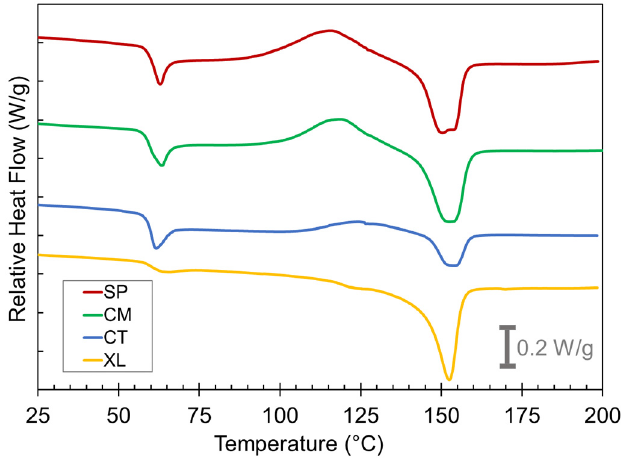
Figure 5. DSC first heat curves for the SP, CM, CT, and XL foams with 6.5 wt% CFA (exo up).